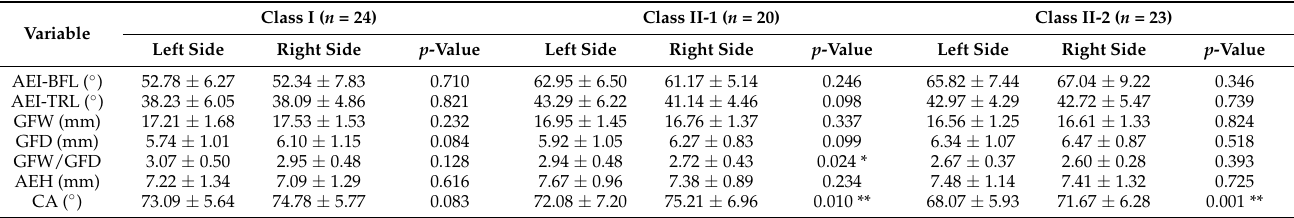
Table 4. Descriptive statistics of the measurements of the temporomandibular joint according to the left and right sides for the three malocclusion